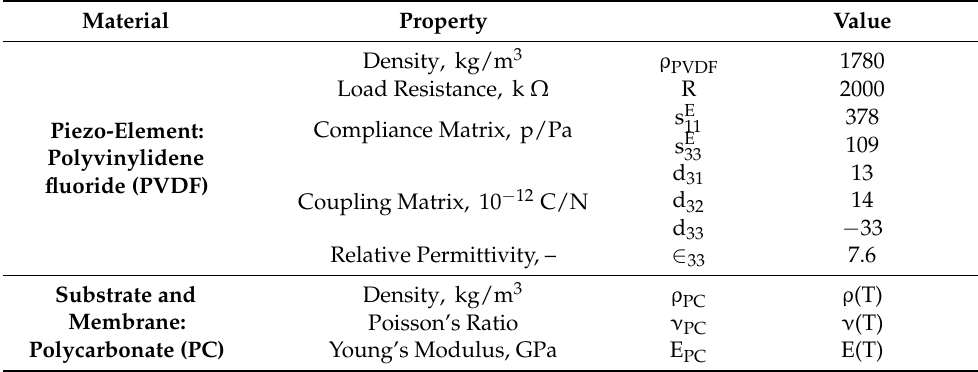
Table 2. Material properties for